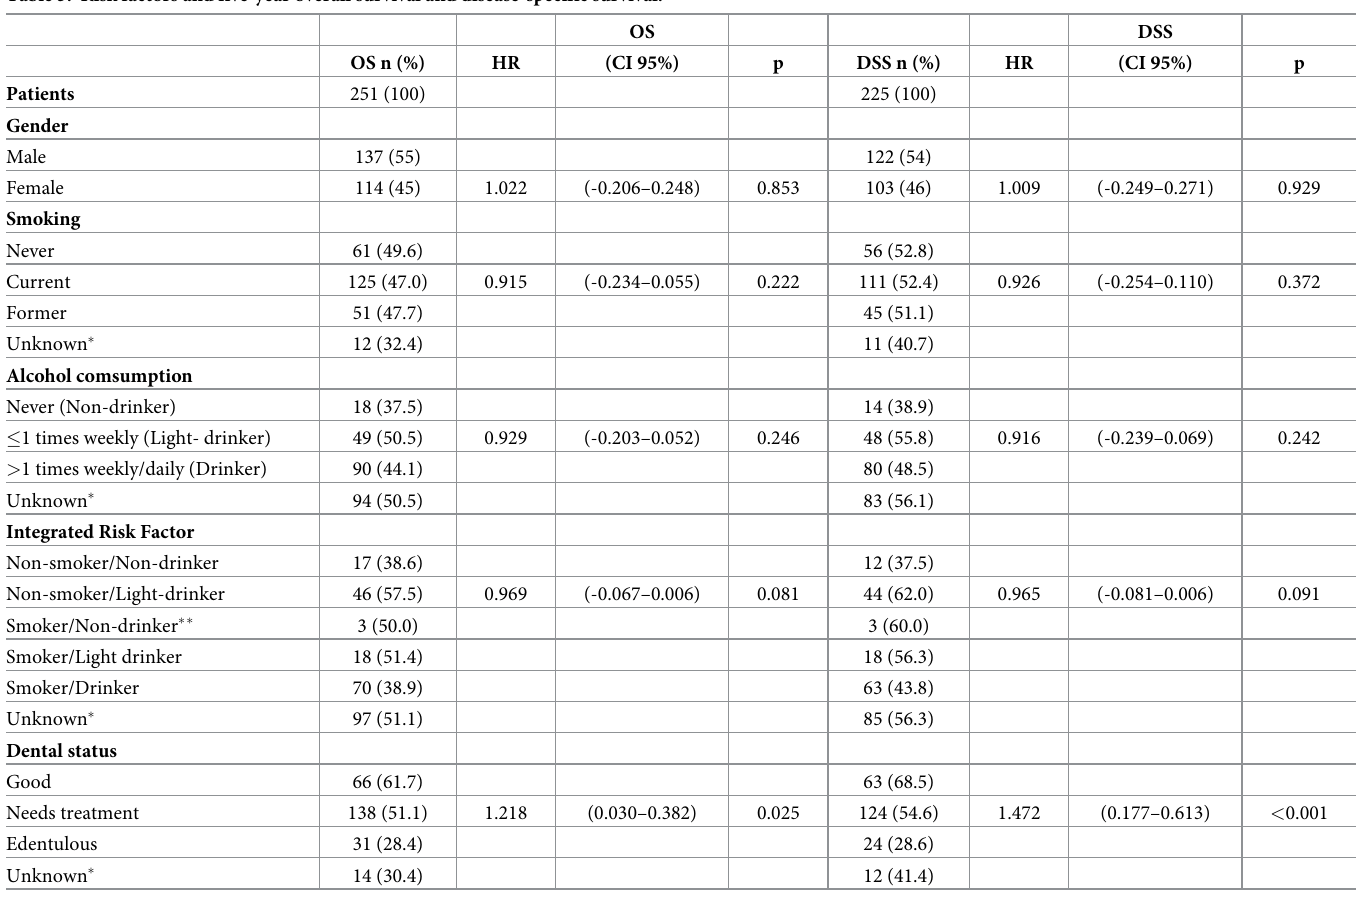
Table 5. Risk factors and five-year overall survival and disease-specific